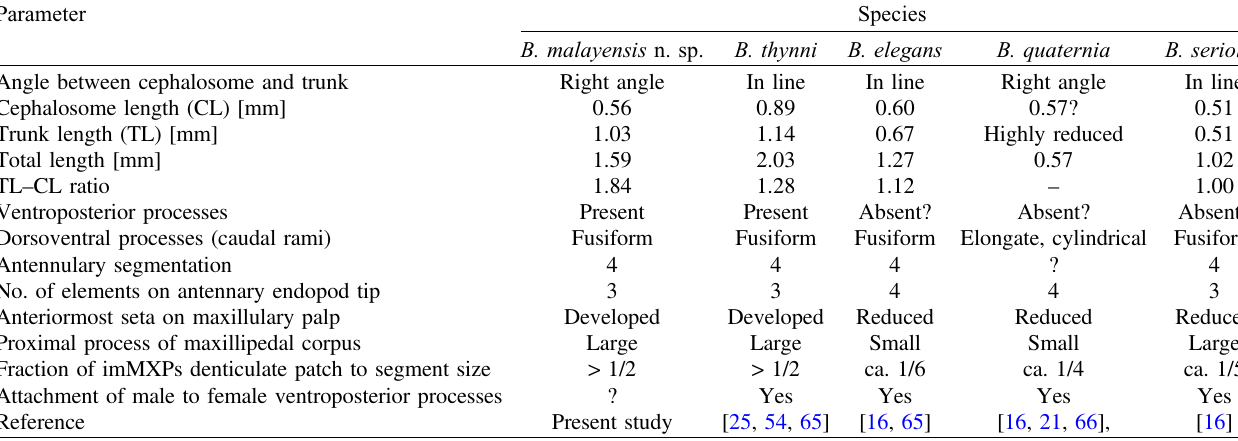
Table 2. A comparison of morphometric and meristic features of males of Brachiella species.